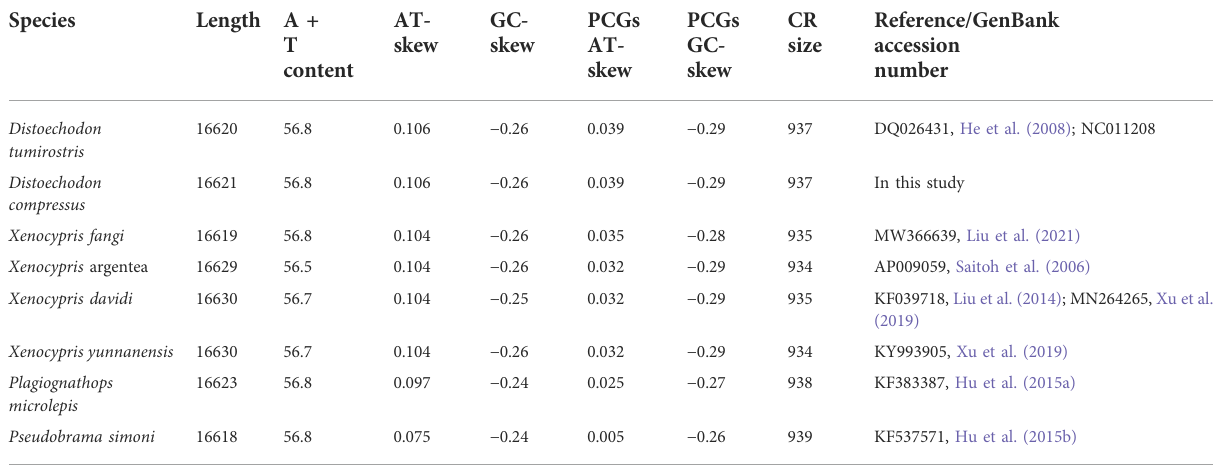
TABLE 1 Comparison of size and base composition of